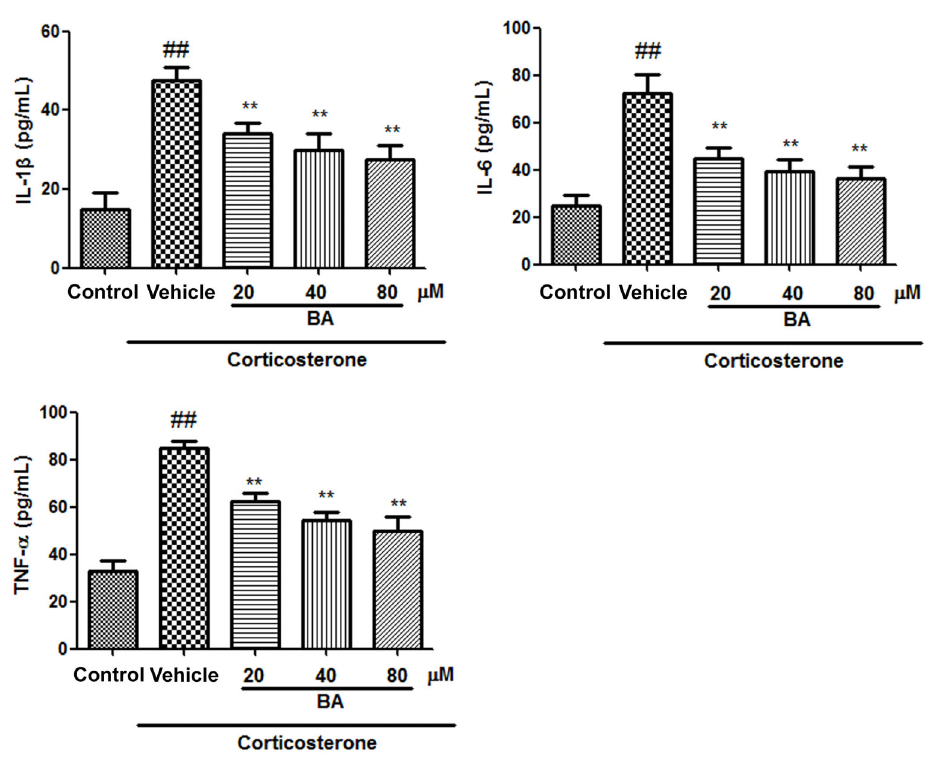
Figure 6. Effects of baicalin (BA) on proin fl ammatory cytokines in PC12 cells. Data are reported as means ± SE (n=8). ## P o 0.01 vs control; **P o 0.01 vs vehicle (ANOVA).